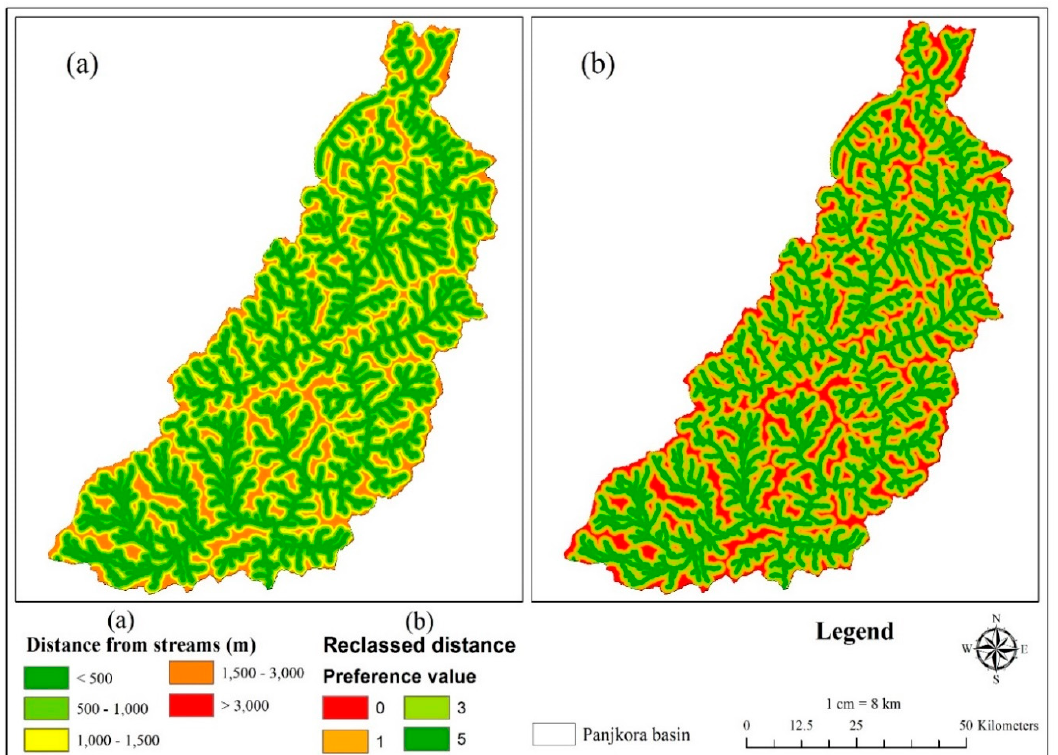
Figure 4. Reciprocal parameter of stream order or Euclidean distance ( a ) distance from the streams ( b ) reclassified raster layer.